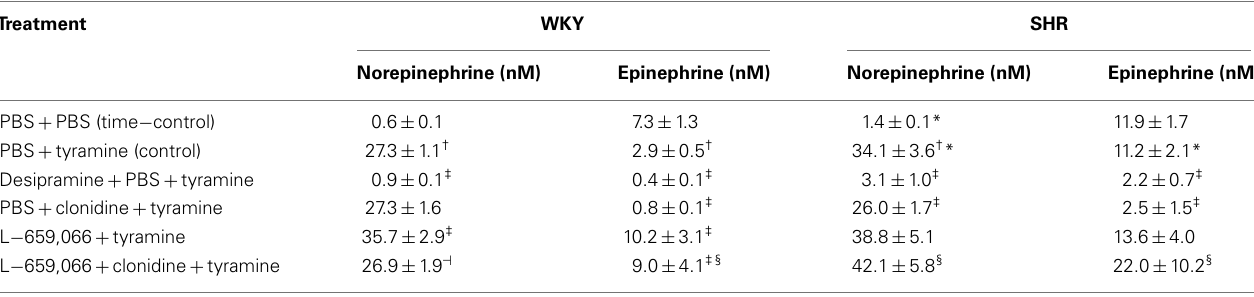
Table 3 |The plasma concentration of norepinephrine and epinephrine at the end of the tyramine-infusion period.